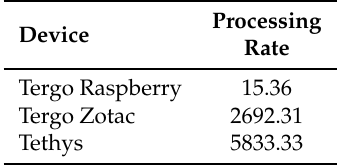
Table 6. Processing rate in messages per